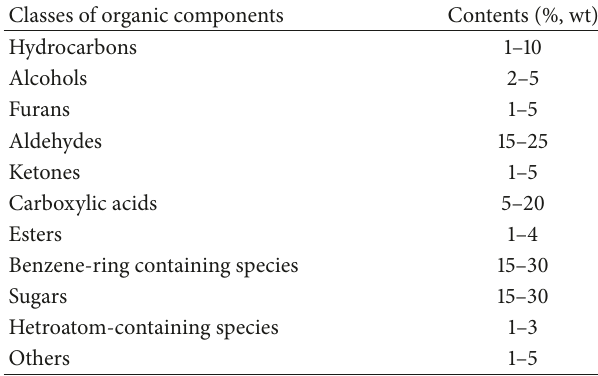
Table 1: Contents of classes of organic components contained in typical